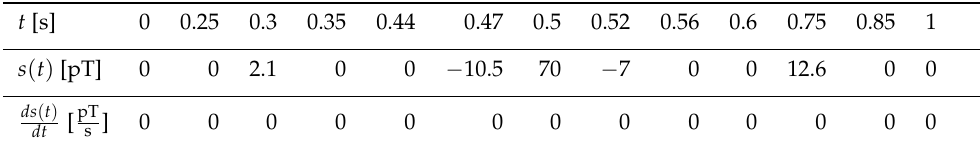
Table A1. Support points for MCG prototype